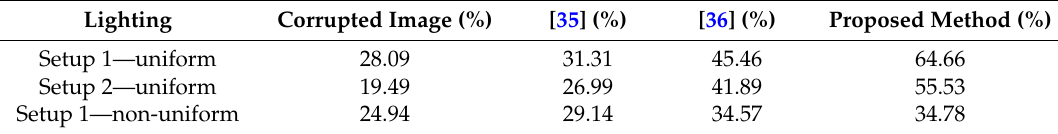
Table 3. Evalution of stereo vision from scatter-corrupted images; the stereo vision method is SGM.